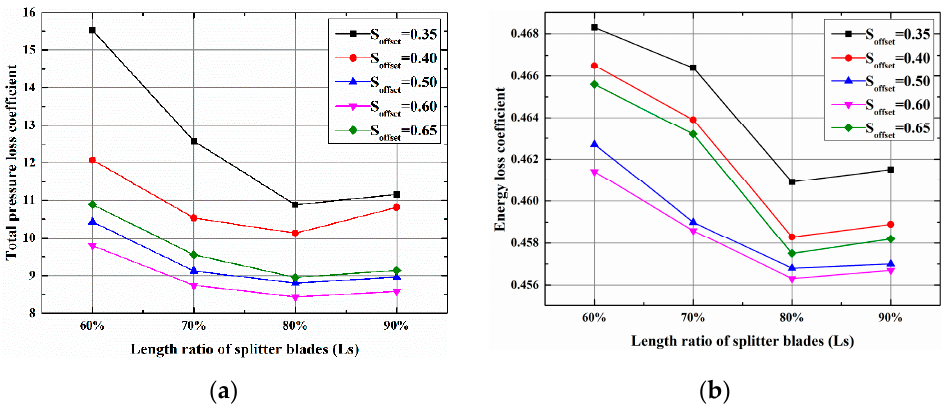
Figure 11. Curve of impeller performance: ( a ) Curve of total pressure loss coefficient; ( b ) curve of energy loss coefficient.